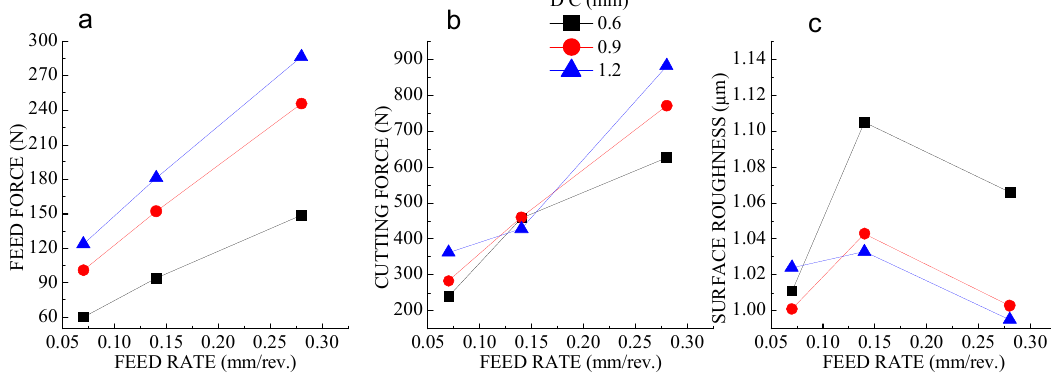
Figure 4. Graphs of ( a ) feed rate vs. feed force; ( b ) feed rate vs. cutting force; and ( c ) feed rate vs. surface roughness at 190 m/min cutting speed .